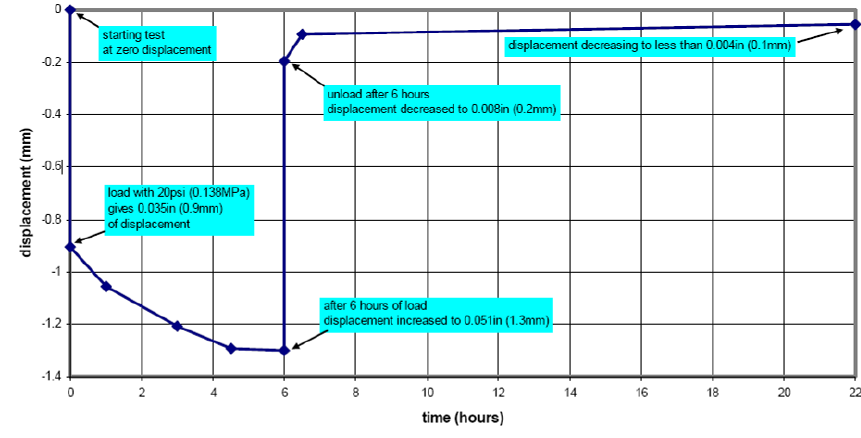
Figure 6: Medium term structural silicone test data. Displacement under 20psi shear stress over 6